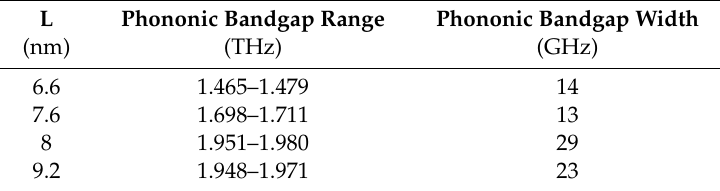
Figure 3. Phononic band structure calculated along the high symmetry points of the Brillouin zone for neck lengths ( a ) 6.6 nm, ( b ) 7.6 nm, ( c ) 8 nm, and ( d ) 9.2 nm of the snowflake shaped phononic crystal.